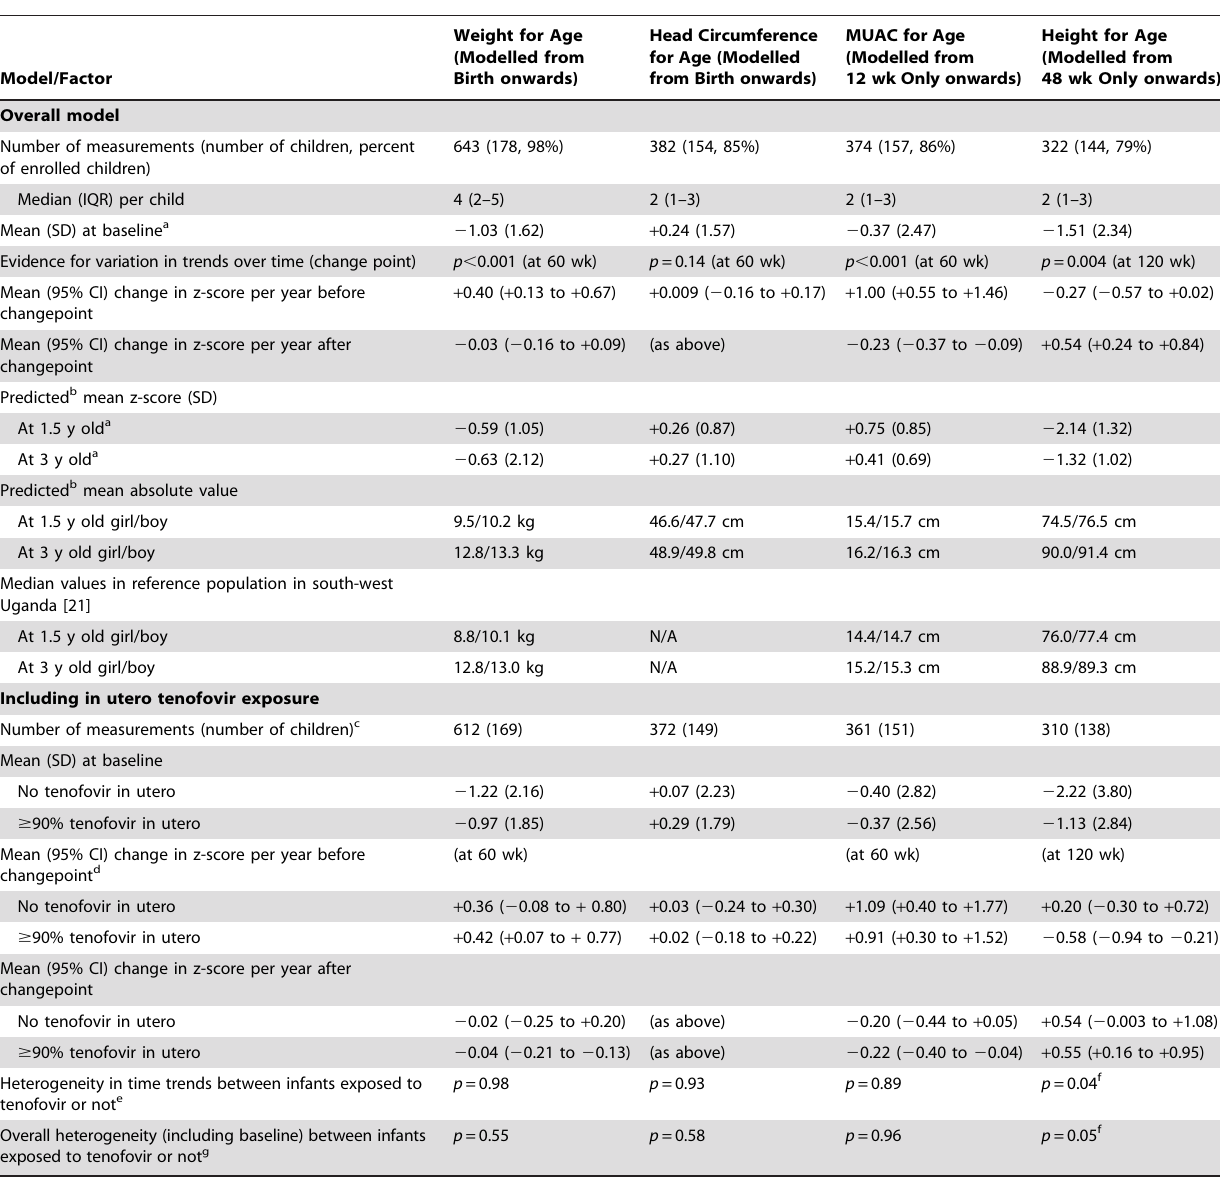
Table 3. Changes in height, weight, head circumference, and MUAC z-scores with age in HIV-exposed infants.